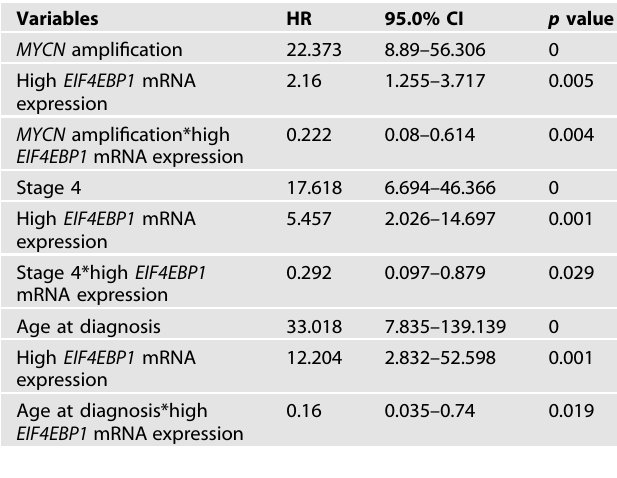
Table 2. Multivariate analysis for overall survival of NB patients in the NRC cohort.